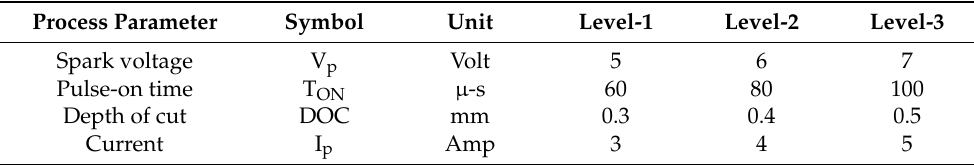
Table 4. Control factors and their level values.